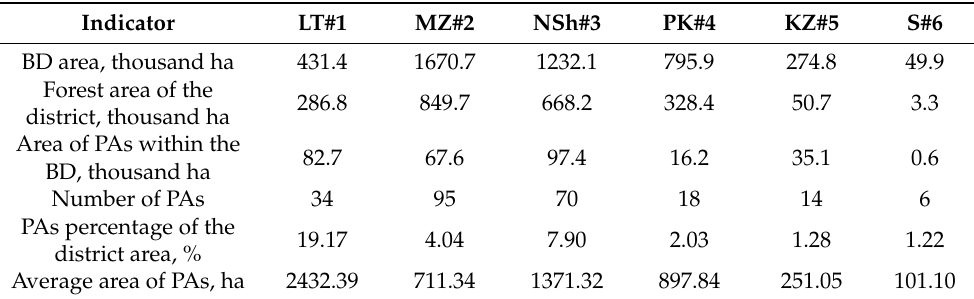
Table 2. Average area and number of PAs in